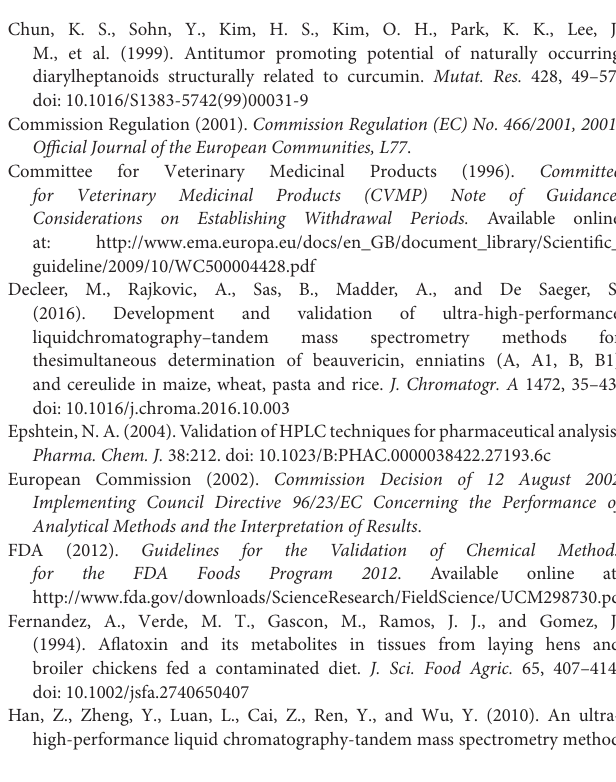
Supplementary Figure 1 | The effect of shaking time on Recovery (%) of AFB1 and AFM1 (mean ± SD, n = 5). Supplementary Figure 2 | All the chromatograms were obtained using mobile phase ratio composed of acetonitrile:water (20:80) at a flow rate of 0.2 ml/min, injection volume of 10 µ l and at column temperature of 25 ◦ C. The horizontal axis shows the time in minutes (min). (A) Chromatogram of standard aflatoxin B1 (AFB1) and aflatoxin M1 (AFM1) (concentrations level; 0.04 µ g/kg for AFB1 and 0.02 µ g/kg for AFM1), (B) chromatogram of AFB1 and AFM1 of spiked (concentrations level; 0.04 µ g/kg for AFB1 and 0.02 µ g/kg for AFM1) liver samples, (C) chromatogram of AFB1 and AFM1 of spiked (concentrations level; 0.04 µ g/kg for AFB1 and 0.02 µ g/kg for AFM1) kidney samples, (D) chromatogram of AFB1 and AFM1 of spiked (concentrations level; 0.04 µ g/kg for AFB1 and 0.02 µ g/kg for AFM1) muscles tissue